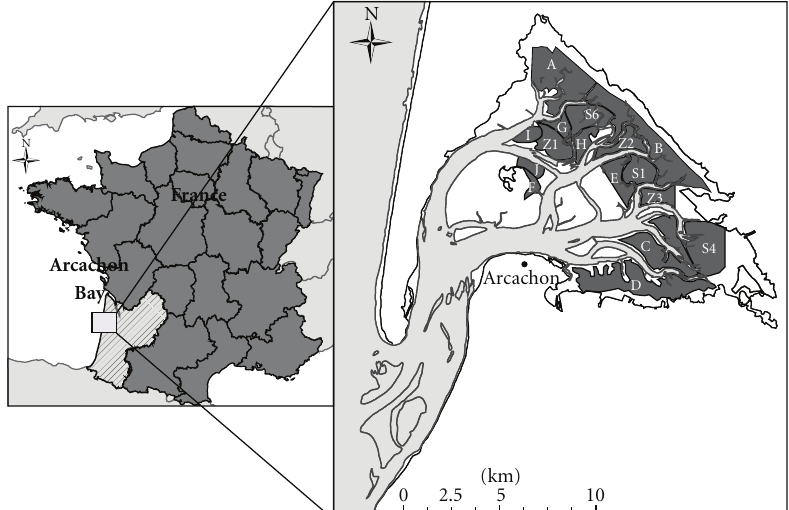
Figure 1: Maps showing the studied site Arcachon Bay (France) and localization of the sampled strata (Sources: ESRI, BD Carthage, Ifremer—M.